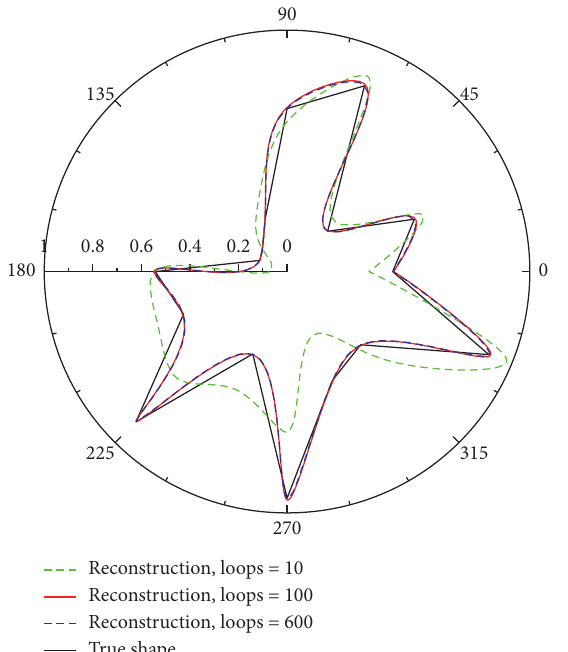
Figure 8: Reconstructed target shape for different iteration loops of the whale optimization algorithm in the second example.